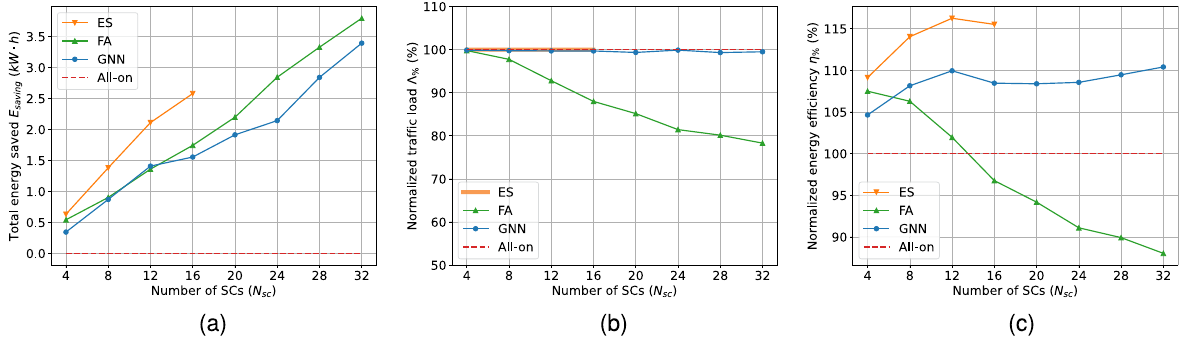
Figure 3. Statistical results from the validation set for different N sc ( a ) Total energy saved E saving . ( b ) Relative traffic load (cid:31) % . ( c ) Relative energy efficiency η % . ES is not executed for N sc > 16 due to huge time